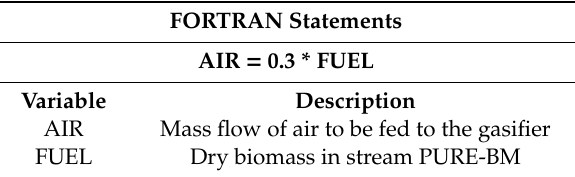
Table A3. FORTRAN statements for calculating air feed to gasifier (AIR-FUEL Calculator Block).